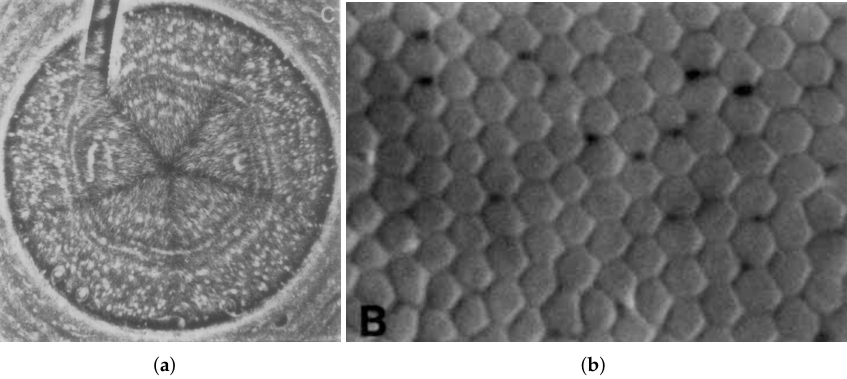
Figure 1. Hexagonal structures occurring in nature. ( a ) Saturn’s north pole [4]. ( b ) Cross-section of human retina